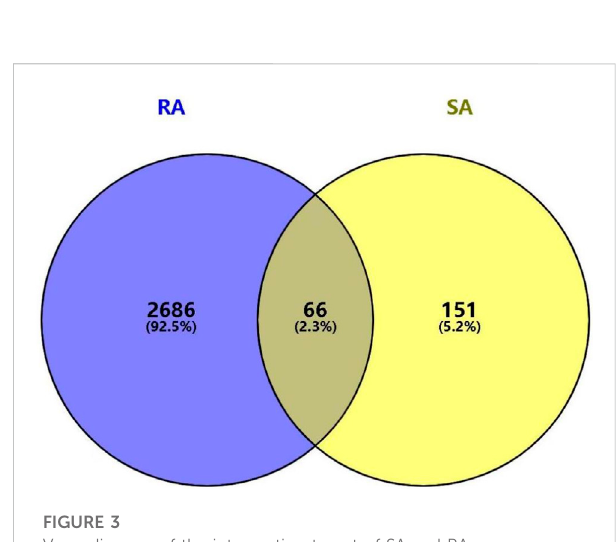
FIGURE 3 Venn diagram of the intersection target of SA and